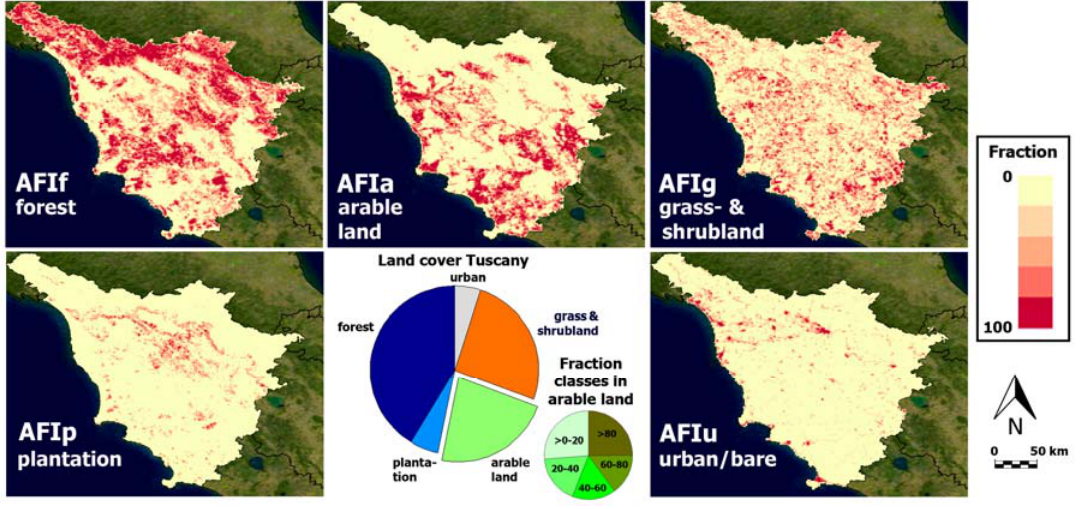
Figure 2. Maps displaying the spatial distribution of area fraction images (AFI) of major CORINE land cover classes resampled to AVHRR pixel size: forest, arable land, grass- and shrubland, plantation and urban/bare land. The two pie charts in the central bottom part of the figure indicate the general land cover of Tuscany (large) and the distribution of five AFIw classes within the arable land (small). All data derived from official AGRIT statistics [30] and CORINE. The geographical location of the area is indicated in Figure 1.